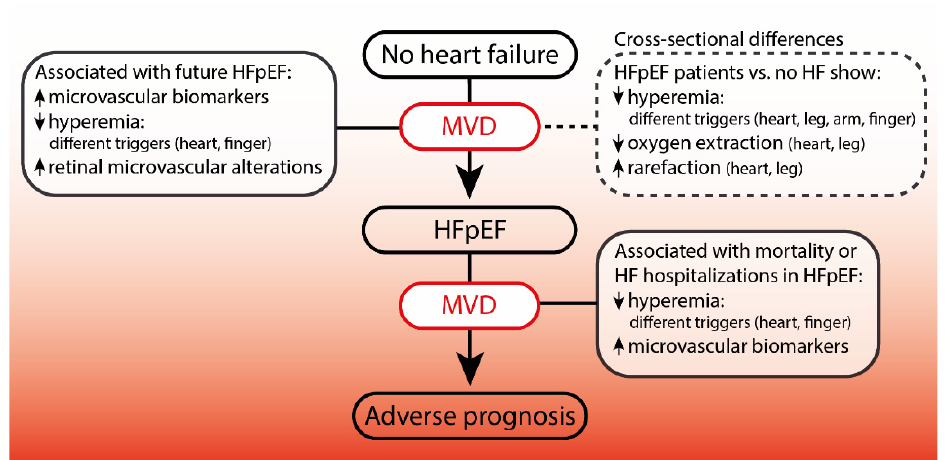
Figure 4. Findings of MVD and their associations within HFpEF. The presence of systemic microvascular dysfunction (MVD) in heart failure with preserved ejection fraction (HFpEF) is suggested by different clinical studies that show (1) cross-sectional microvascular differences between HFpEF and controls, (2) associations between baseline measures of microvascular function and incident HFpEF, and (3) associations between baseline microvascular measures in HFpEF patients and adverse disease progression defined by all-cause mortality or heart failure (HF) hospitalization. Due to current evidence limitations, causality between MVD and HFpEF requires further research.